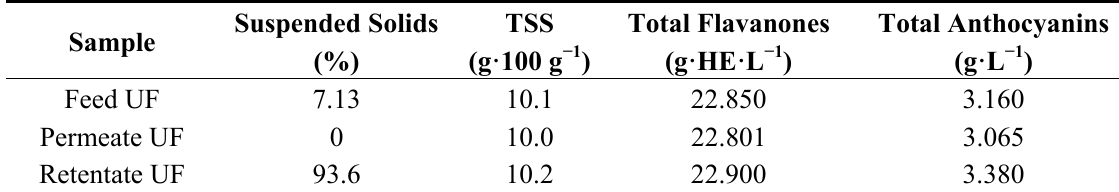
Table 4. Analytical evaluation of anthocyanins and flavanones in samples of press liquor coming from the UF treatment.